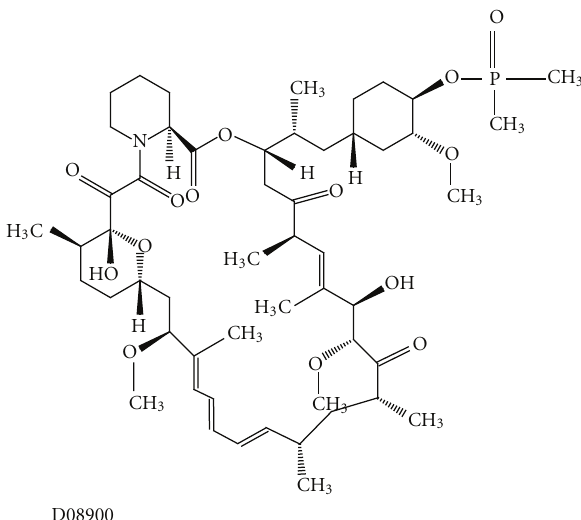
Figure 12: Molecular structure of ridaforolimus extracted from KEGG database